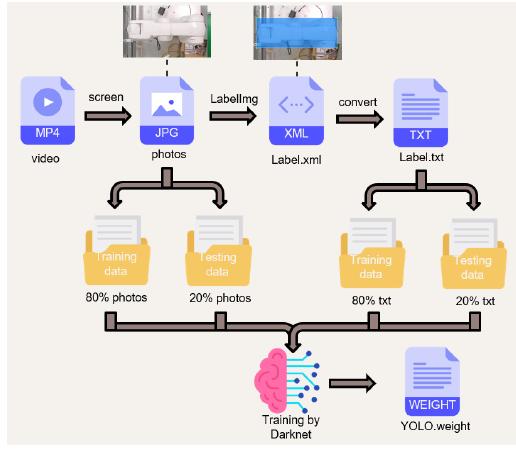
Figure 3. Customized dataset training steps.